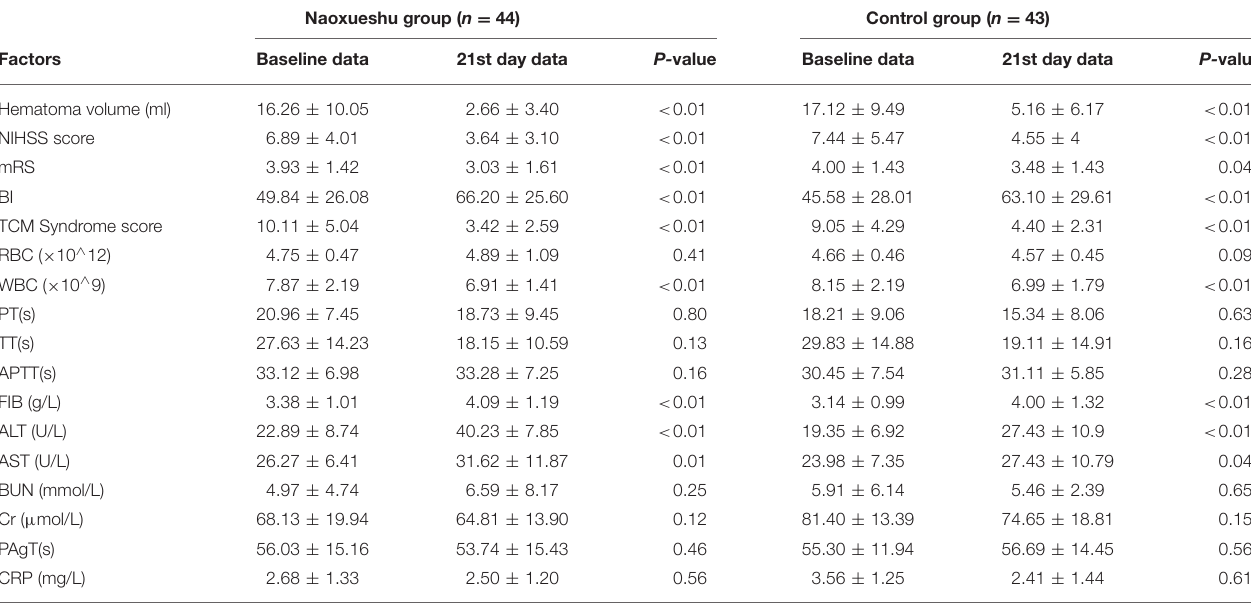
TABLE 3 | Comparison of baseline data and the data of the 21st day after